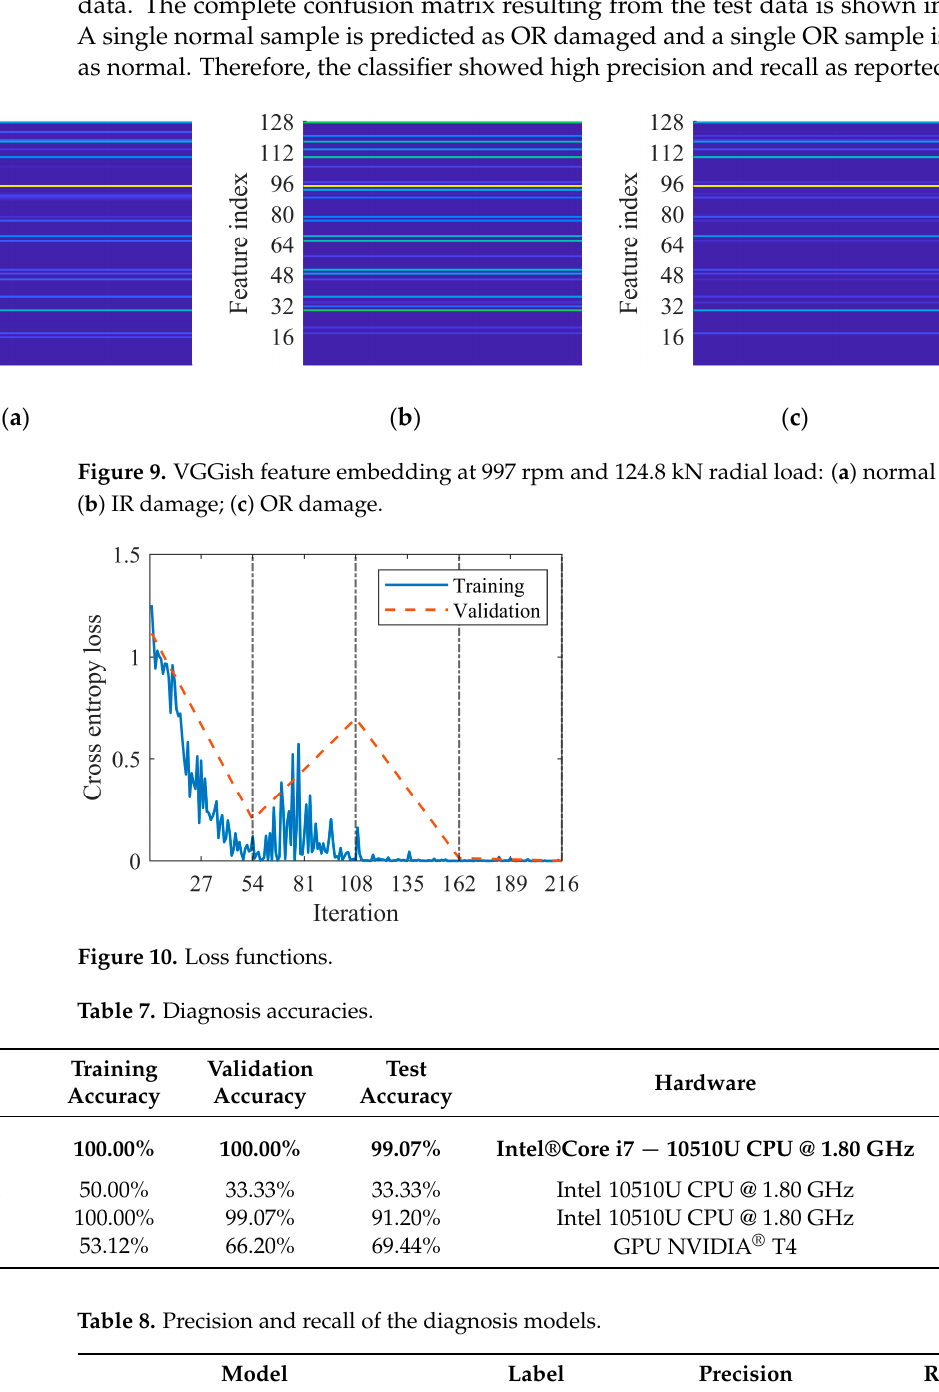
Figure 11. Test confusion matrix. Table 7. Diagnosis accuracies.